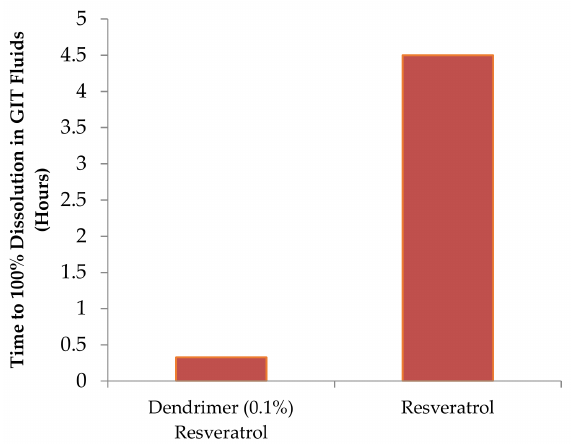
Figure 5. Dissolution profile of dendrimer–resveratrol